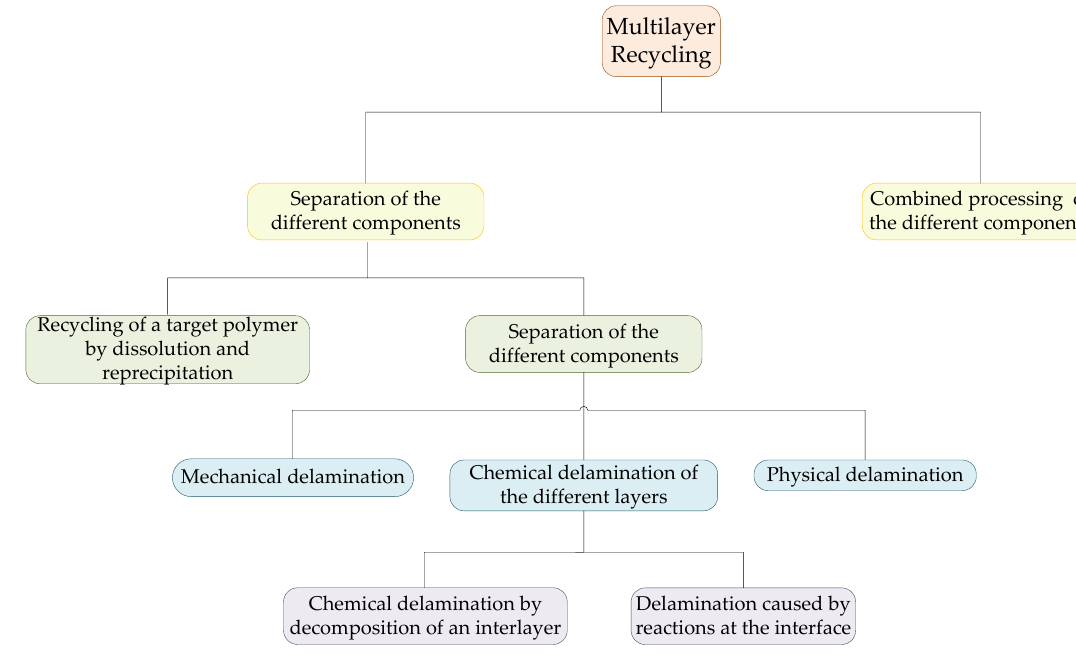
Figure 7. Schematic overview of the introduced recycling methods of multilayer packaging.